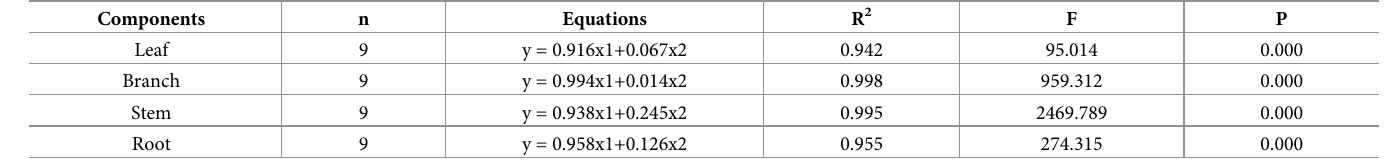
Table 4. Multiple linear regressions of carbon storage fraction of different